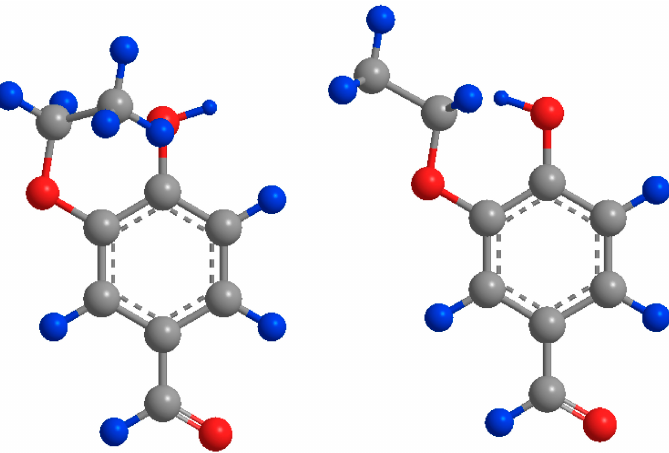
Figure 4. Potential positions of the ethoxy group of 3-ethoxy-4-hydroxybenzaldehyde sterically hindering the oxygen ( left ) and hydrogen ( right ). Carbon atoms (grey) oxygen (red) hydrogen